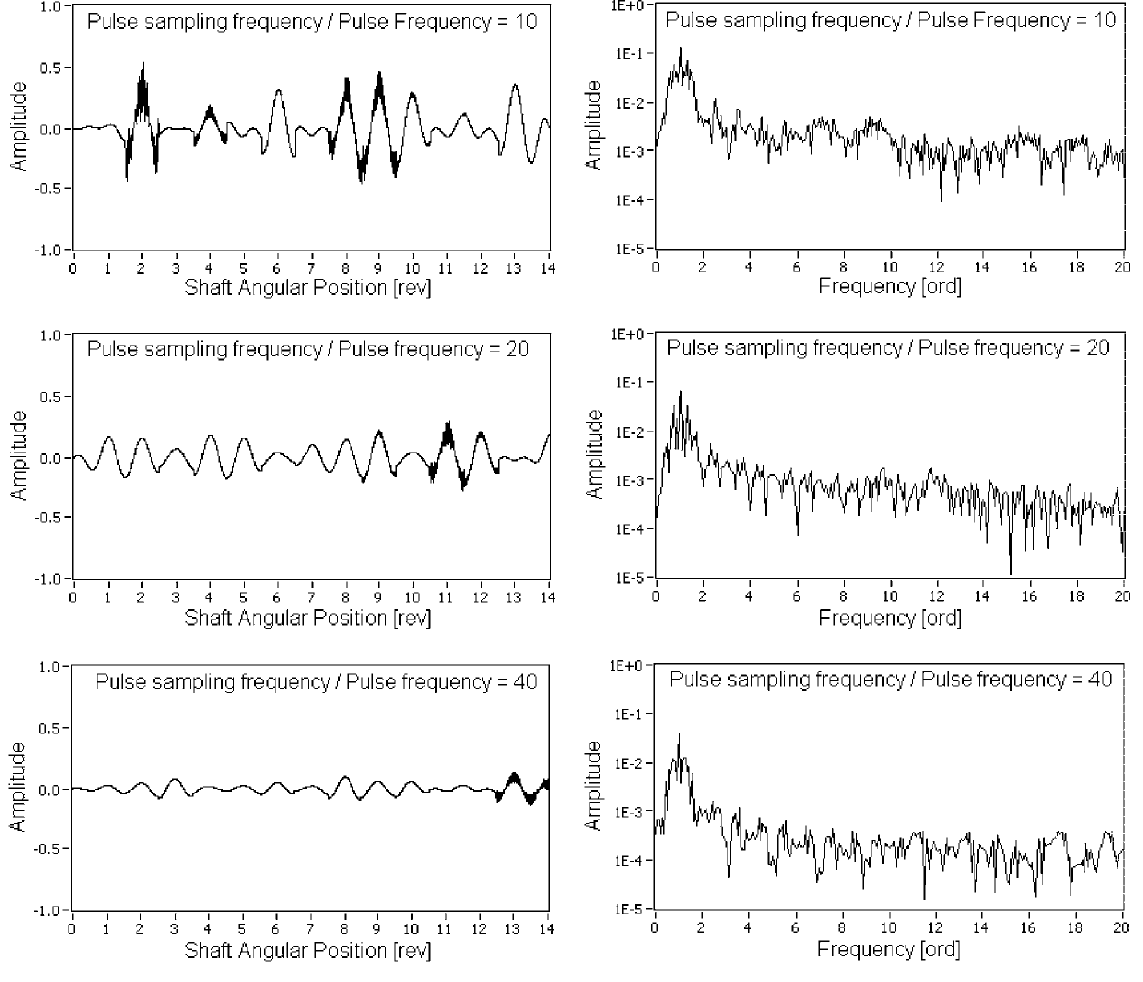
Fig. 6. Noise due to the pulse sampling